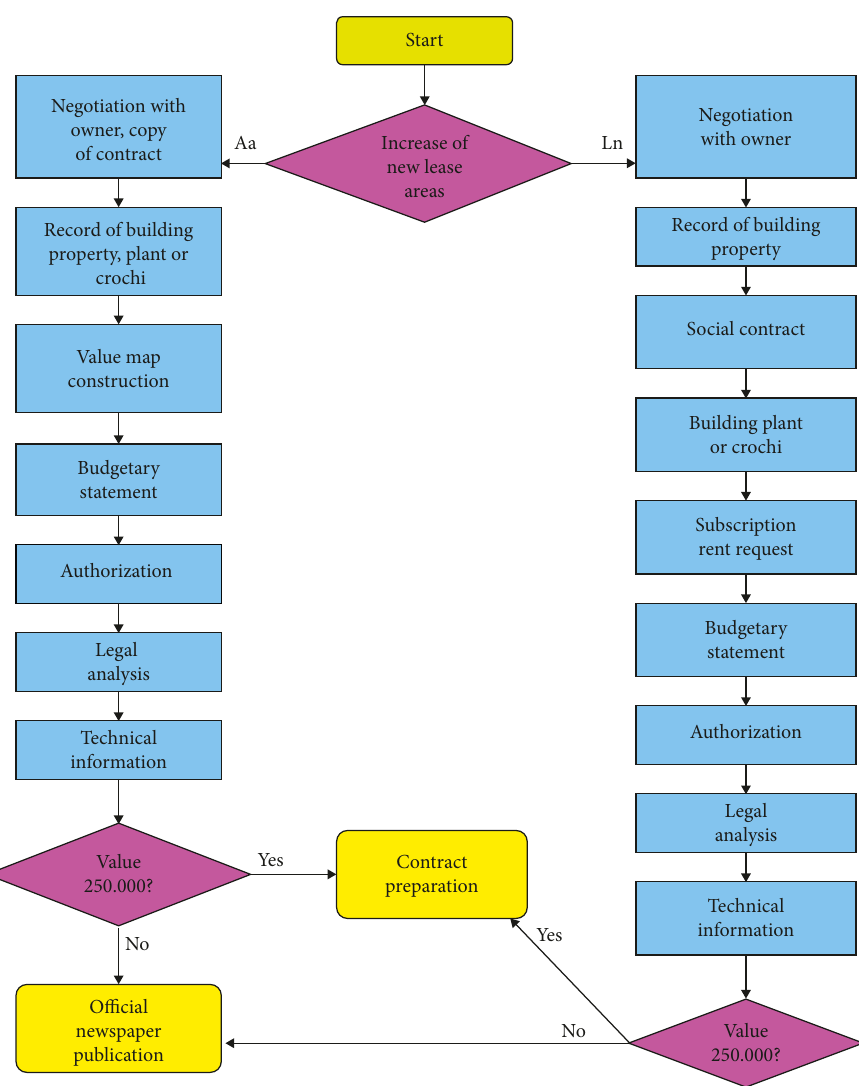
Figure 5: Representation of workflows. The extraction of knowledge from a workflow depends on the type of analysis adopted. Traditional models do not incorporate new analyses from other fields of science, such as biology and physics. This point constitutes an empty space that currently seeks to find in the firm adequate space for agents, innovation potential and flexibility for hybrid workflows.